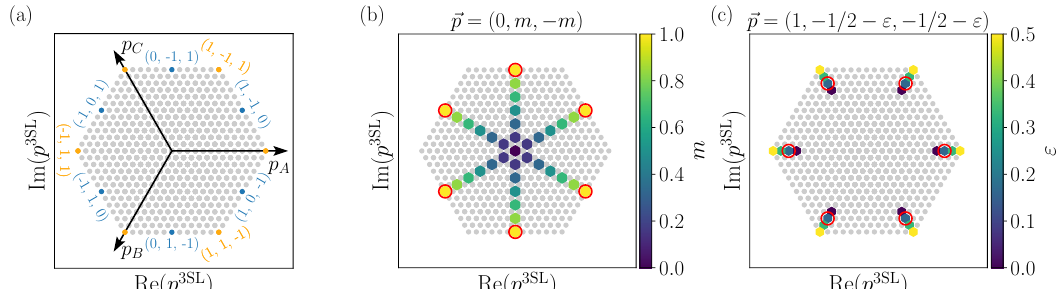
Figure 8: 3SL order parameter histogram in the complex plain. (a) A classical state ) gives a point in the histogram accord- with sublattice polarizations (cid:126) p = ( p , p , p A B C ing to the three axes shown in black. The blue dots at the centers of the hexago- nal boundary correspond to states of type (cid:126) p = ( 1, − 1,0 ) . The orange dots at the vertices of the hexagonal boundary correspond states of type (cid:126) p = ( 1,1, − 1 ) . (b) The classical ordering pattern (cid:126) p = ( 0, m , − m ) (with zero net polarization) yields six peaks along the axis connecting the center to the centers of the boundary faces [ θ = π/ 6 + l π/ 3, l ∈ { 0,...,5 } ] , where the radius is proportional to the sublattice l magnetization m . The red circles show the positions of the maxima found in the full histograms of the 3SL normal and 3SL subradiant phases. (c) The classical ordering pattern (cid:126) p = ( 1, − 1 / 2 − (cid:34) , − 1 / 2 − (cid:34) ) gives six peaks along the axis connecting the = l π/ 3, l ∈ { 0,...,5 } ] . The radius center with the vertices of the outer hexagon [ θ l of the peaks increases with (cid:34) . The red circles show the positions of the maxima found in the full histograms of the 3SL superradiant